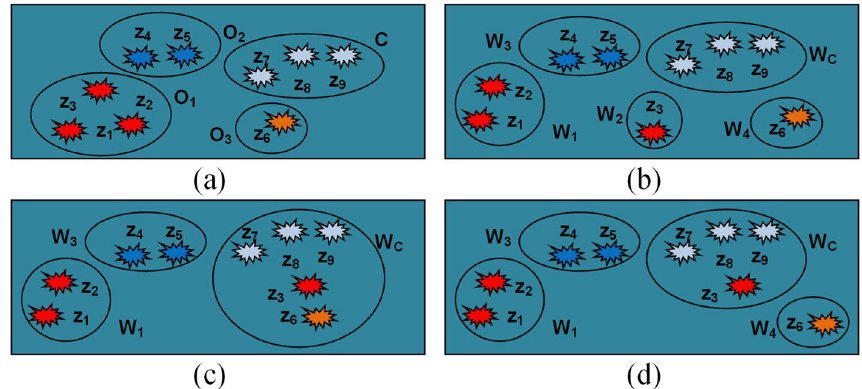
Fig. 4 General partitioning algorithm illustration. a General original partition, b The 1st type of partition, c The 2nd type of partition, d The 3rd type of partition